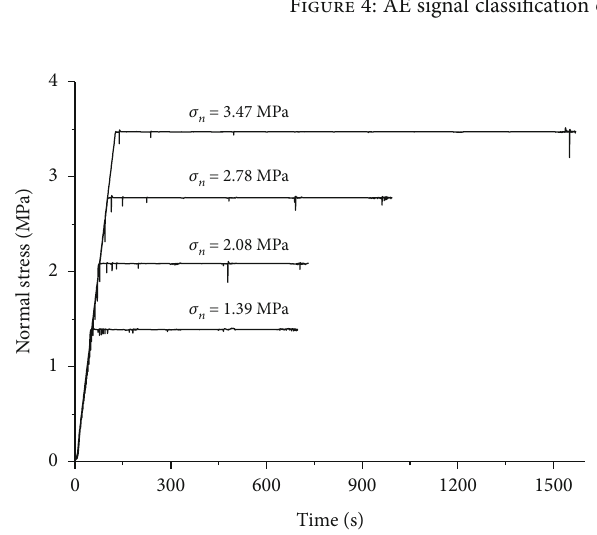
Figure 5: Normal stress-time